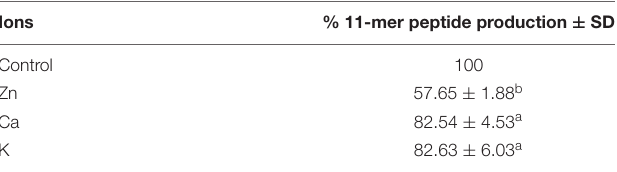
TABLE 6 | Evaluation of the effects of zinc, calcium, and potassium addition on the production of 11-mer peptide from β